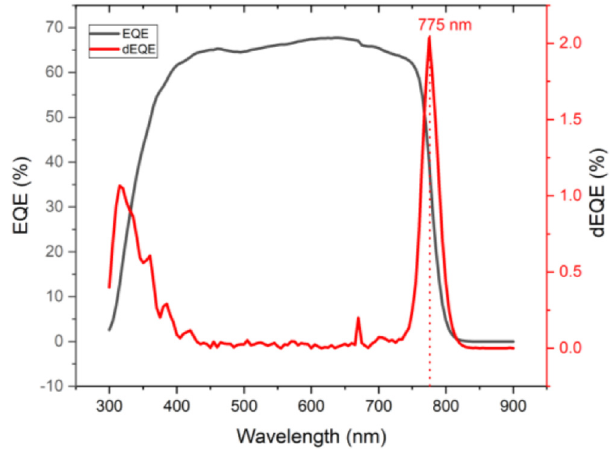
Fig. 9. External quantum ef fi ciency (EQE) measurements and determination of the in fl ection point.